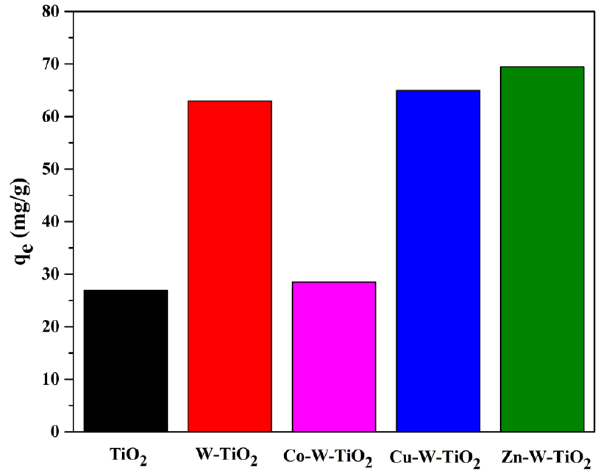
Figure 19. The adsorption capacities of W ‐ TiO 2 , Co ‐ W ‐ TiO 2 , Cu ‐ W ‐ TiO 2 , and Zn ‐ W ‐ TiO 2 .